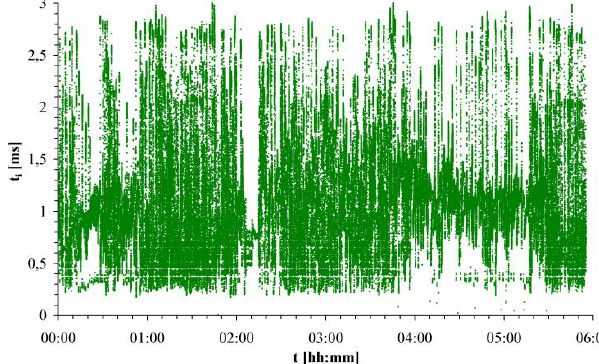
Fig. 13. Times of fuel injections measured on the distance of 456